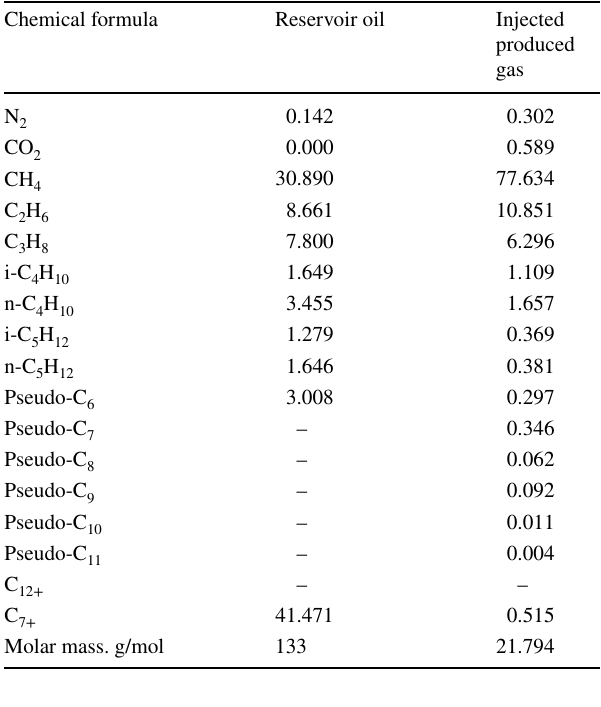
Table 2 Blend composition of the reservoir oil and injected produced gas (mole fraction, %) Chemical formula Reservoir oil Injected